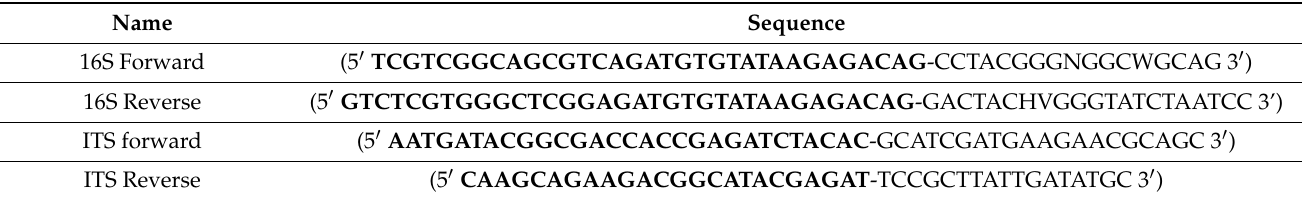
Table 2. Primer information. Bolded primer sequences before the hyphen are the Illumina overhang adapter sequences. Primer sequences after the hyphen correspond to the locus-specific